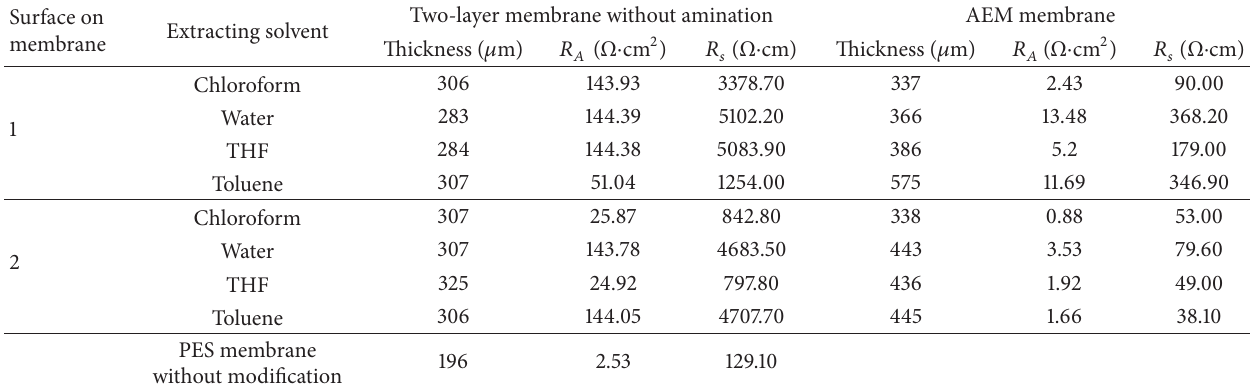
Table 4: Ion-exchange capacity, areal resistance, specific resistance, and membrane thickness averages for the prepared surface modified PES membranes before and after amination.